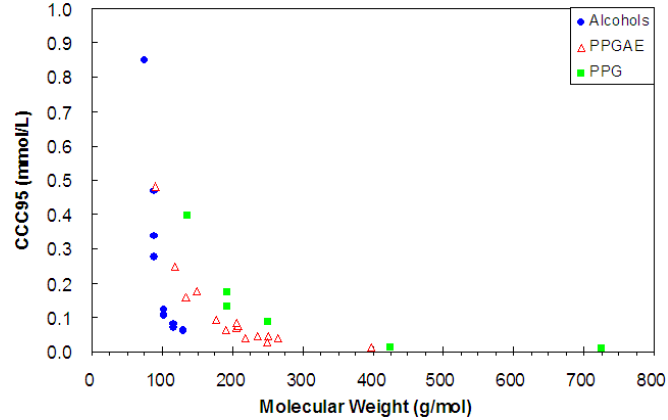
Figure 6. CCC95 (mmol/L) versus molecular weight for the 36